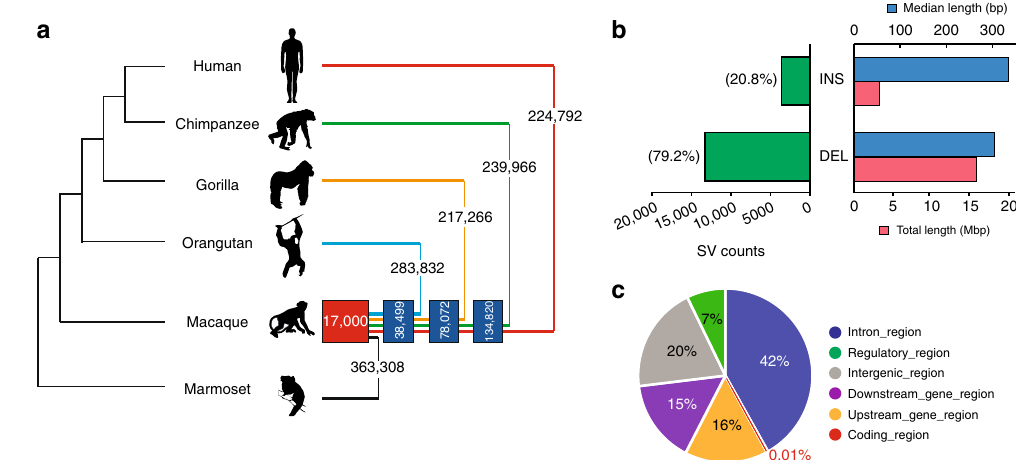
Fig. 4 Summary of the ape-speci fi c structural variants (ASSVs). a The cladogram depicts the phylogenetic relationship among the studied primate species, including human, three great apes, rhesus macaque, and common marmoset. The numbers of the identi fi ed SVs by genome-pairwise comparisons are indicated. The numbers in the blue boxes represent the overlap for different pairwise results. The number in the red box indicates the identi fi ed 17,000 ASSVs. Gibbon (lesser ape) was not included due to the poor quality of the published genome assembly. We used the common marmoset genome assembly generated by short-read sequencing data to fi lter the SVs that occurred in the rhesus monkey lineage (bottom panel). b Statistics of ASSVs. c Pie plot for ASSV